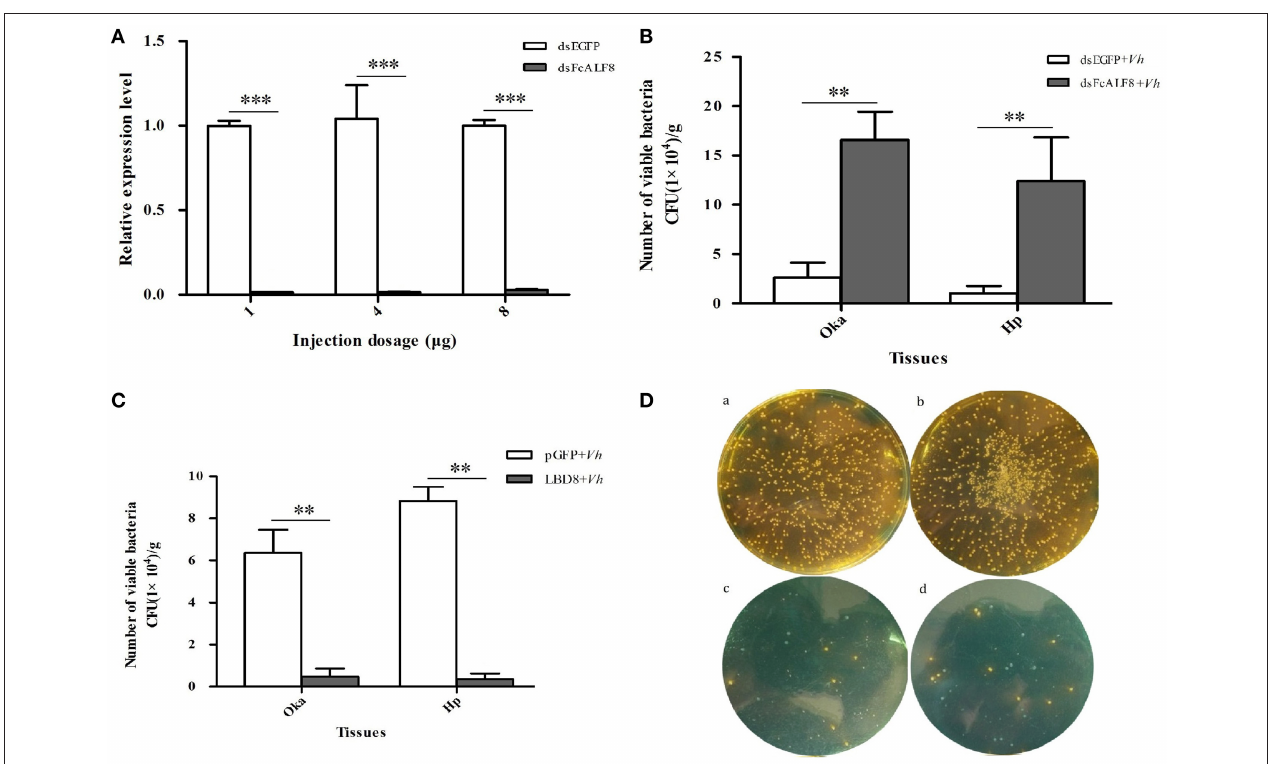
FIGURE 4 | In vivo anti-bacterial function of FcALF8 in F. chinensis . (A) showed the silence efficiency of FcALF8 after injection of 1, 4, and 8 µ g dsRNA. dsEGFP, injected with EGFP dsRNA; dsFcALF8, injected with FcALF8 dsRNA. (B) showed total viable bacteria counts in lymphoid organ (Oka) and hepatopancreas (Hp) of shrimp injected with dsRNA and V. harveyi . dsEGFP + Vh , injected with EGFP dsRNA and V. harveyi ; dsFcALF8 + Vh , injected with FcALF8 dsRNA and V. harveyi . (C) showed total viable bacteria counts in lymphoid organ (Oka) and hepatopancreas (Hp) of shrimp injected with synthetic peptide and V. harveyi . pGFP + Vh , injected with synthetic pGFP peptide and V. harveyi ; LBD8 + Vh , injected with synthetic LBD8 peptide and V. harveyi . (D) showed spread plates of Oka and hepatopancreas homogenate of shrimp injected with synthetic peptide and V. harveyi . (a), Oka homogenate of shrimp injected with pGFP and V. harveyi ; (b), hepatopancreas homogenate of shrimp injected with pGFP and V. harveyi ; (c), Oka homogenate of shrimp injected with LBD8, and V. harveyi ; (d), hepatopancreas homogenate of shrimp injected with LBD8 and V. harveyi . Yellow colonies were detected as V. harveyi , while green colonies were detected as Vibrio campbellii . Significant differences at P < 0.01 and P < 0.001 between two treatments were shown with two stars (**) and three stars (***),